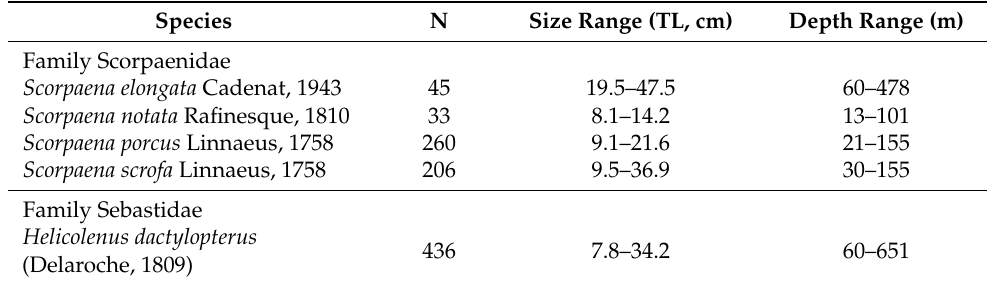
Table 1. List of the selected species: number of collected females (N), size (TL), and depth range at which the individuals were caught are presented. Species N Size Range (TL, cm) Depth Range